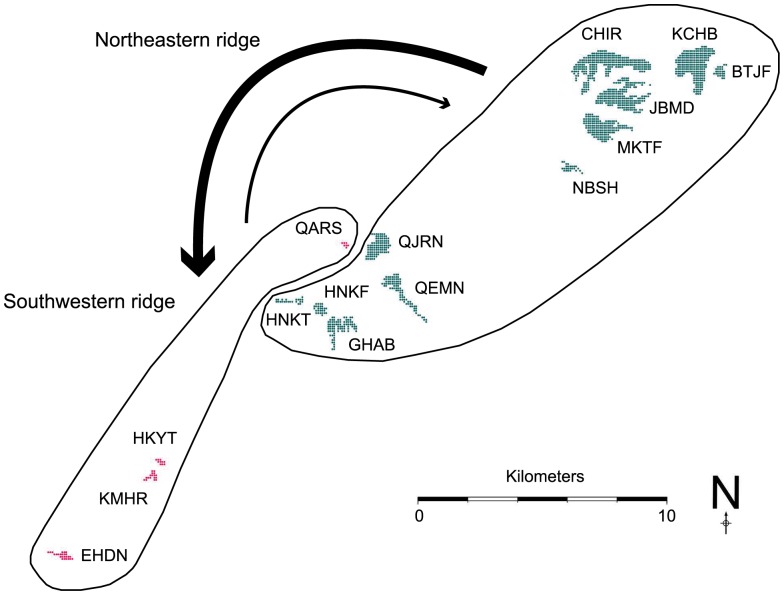
Asymmetric Northeast-Southwest migration of Abies cilicica in Lebanon.The Northeastern and Southwestern ridges correspond to the two genetically-distinct demes assigned by baps
[71]. Populations of the Northeastern ridge are plotted in green color while those of the Southwestern ridge are plotted in magenta color. A likelihood-based Bayesian assignment test [79] performed in geneclass2 [77] allowed the detection, in the Southwestern ridge, of 3 F0 migrants originating from the Northeastern ridge. It has also allowed the detection, in the Northeastern ridge, of 1 F0 migrant originating from the Southwestern ridge, suggesting an asymmetric Northeast-Southwest migration.